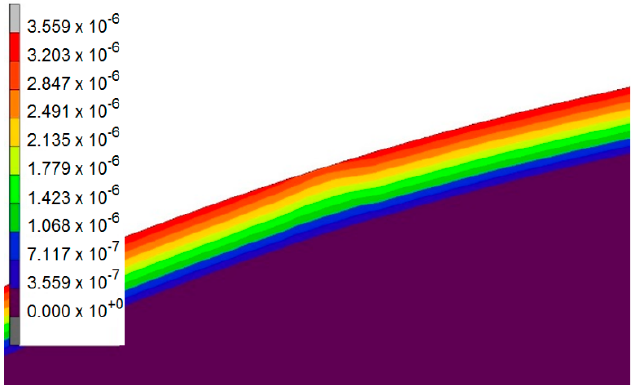
Figure 24. FEM simulation of wear for AA ‐ 5083 ‐ F380 with a load of 0.6 kN and at 200 rpm (wear index per revolution).